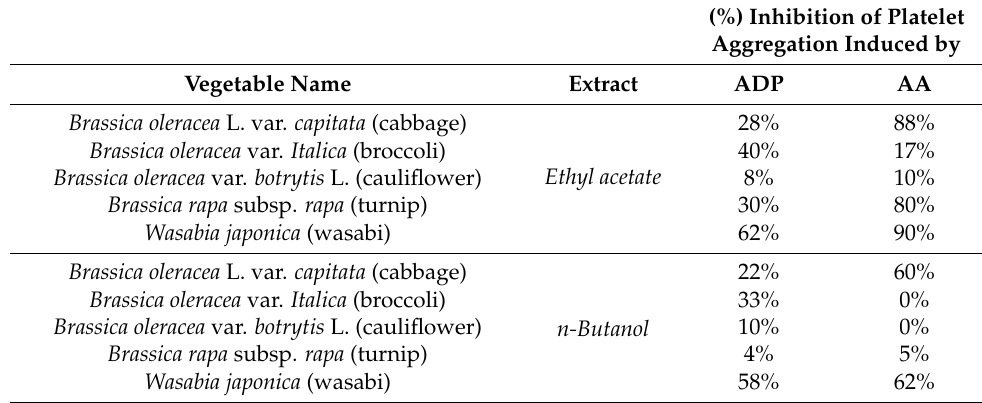
Table 2. Effects of extracts of selected cruciferous vegetables on human-platelet activation induced by ADP and AA